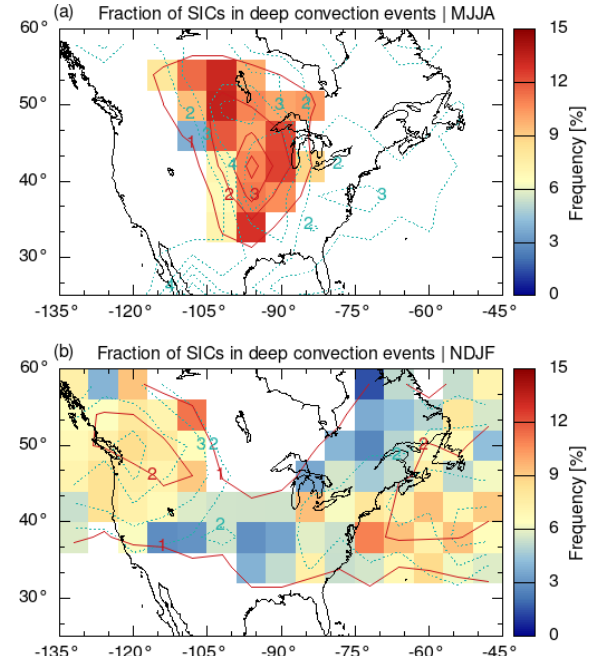
Figure 6. Fraction of deep-convection events related to SICs. The red contour lines indicate the occurrence frequencies of deep con- vection, and blue dotted contour lines show the occurrence frequen- cies of SICs.